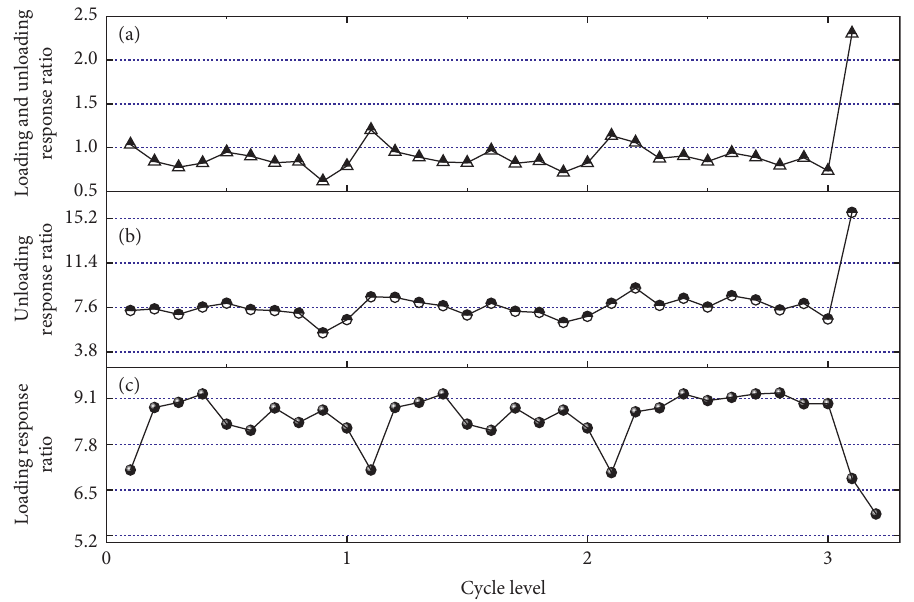
Figure 5: Loading and unloading response